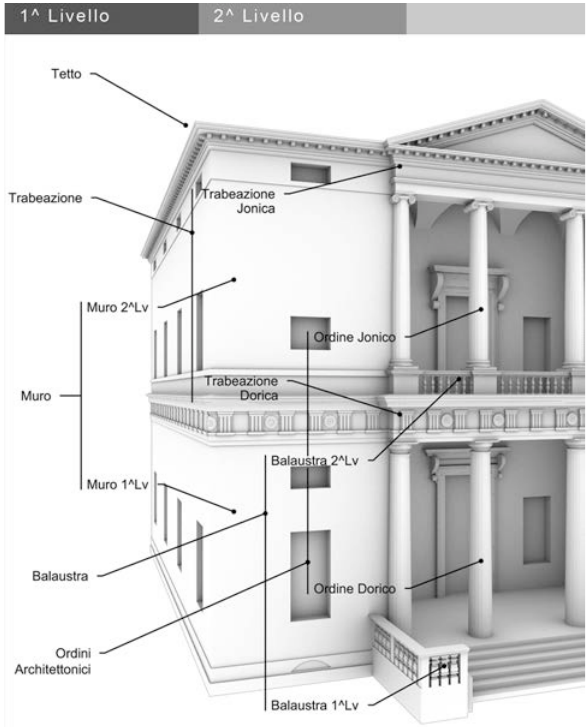
Figure 7. Villa Pisani a Montagnana: semantic structure of the 3D model; 1st and 2nd level.